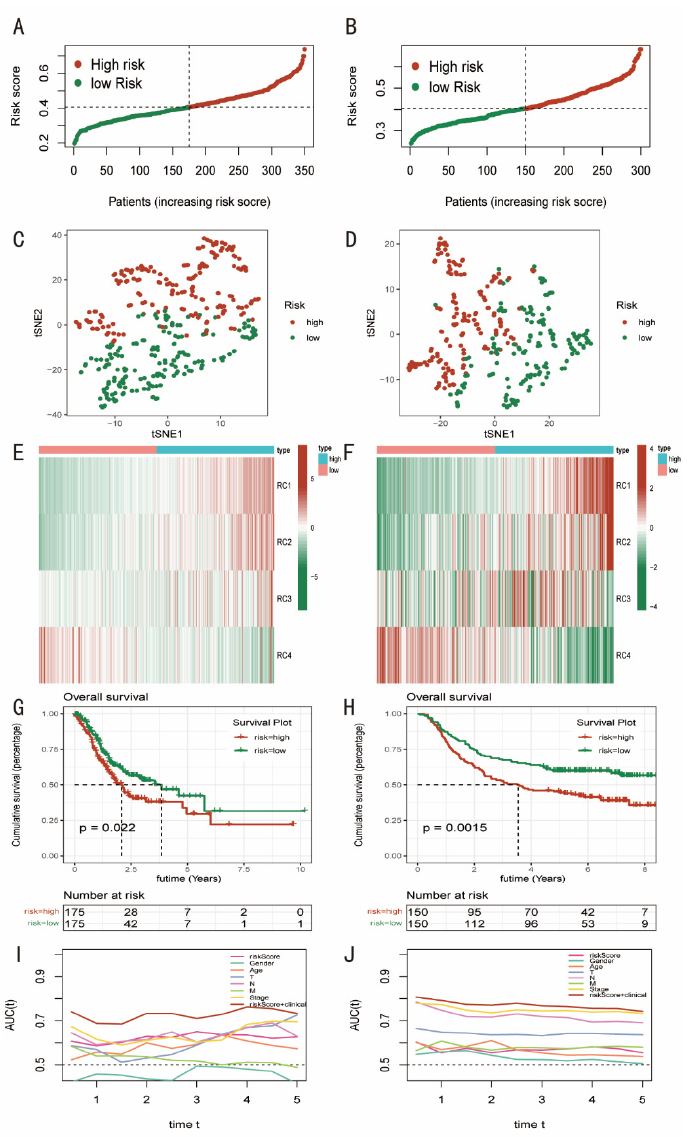
Figure 4. Evaluating the pyroptosis-related prognostic model of GC. ( A , B ) The patients with GC were divided into high- and low-risk groups, based on the median riskScore. ( C , D ) T-SNE was applied to assess the ability of the pyroptosis-related prognostic model to distinguish between GC patients with high- and low-risk. ( E , F ) The PCA establishment factor scores of RC1, RC2, and RC3 increased in the high-risk group than in the low-risk group, while the score of RC4 was higher in the low-risk group. ( G , H ) Patients in the low-risk group had improved survival, compared with those in the high-risk group. ( I , J ) The area under curve (AUC) values was obtained, which is stable for five years.